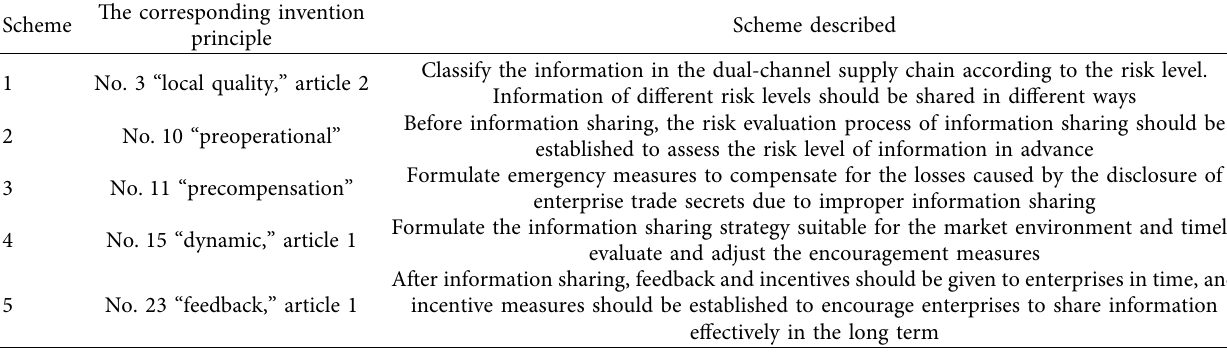
Table 2: Some schemes based on the principle of